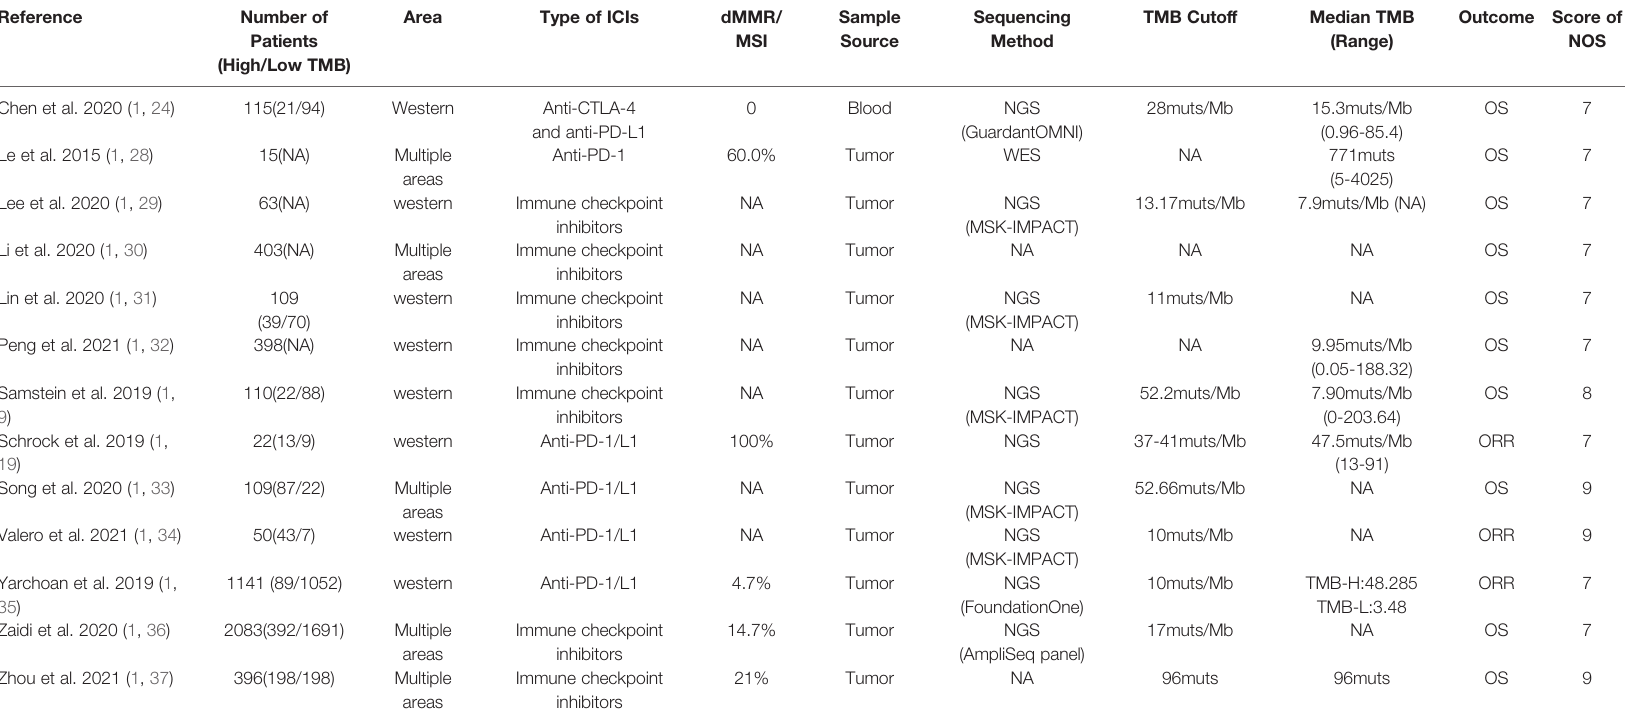
TABLE 1 | Characters of included studies in the